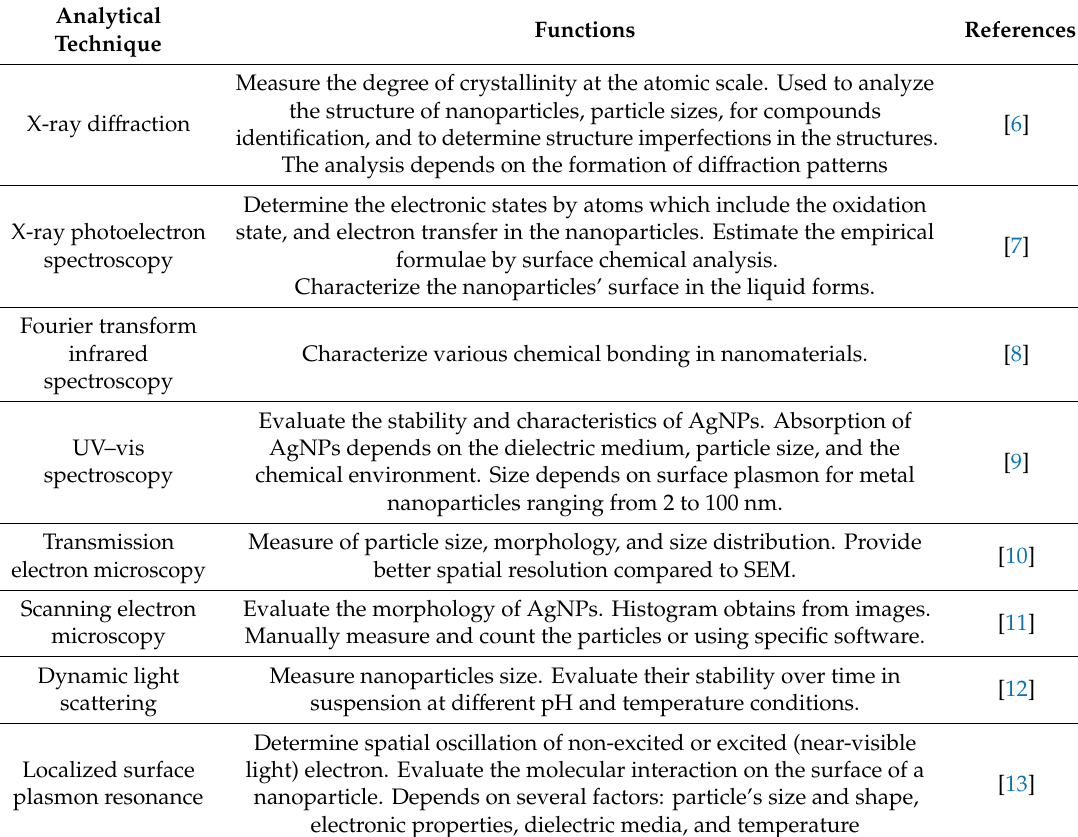
Table 1. Analytical techniques and their basic functions in the characterization of silver